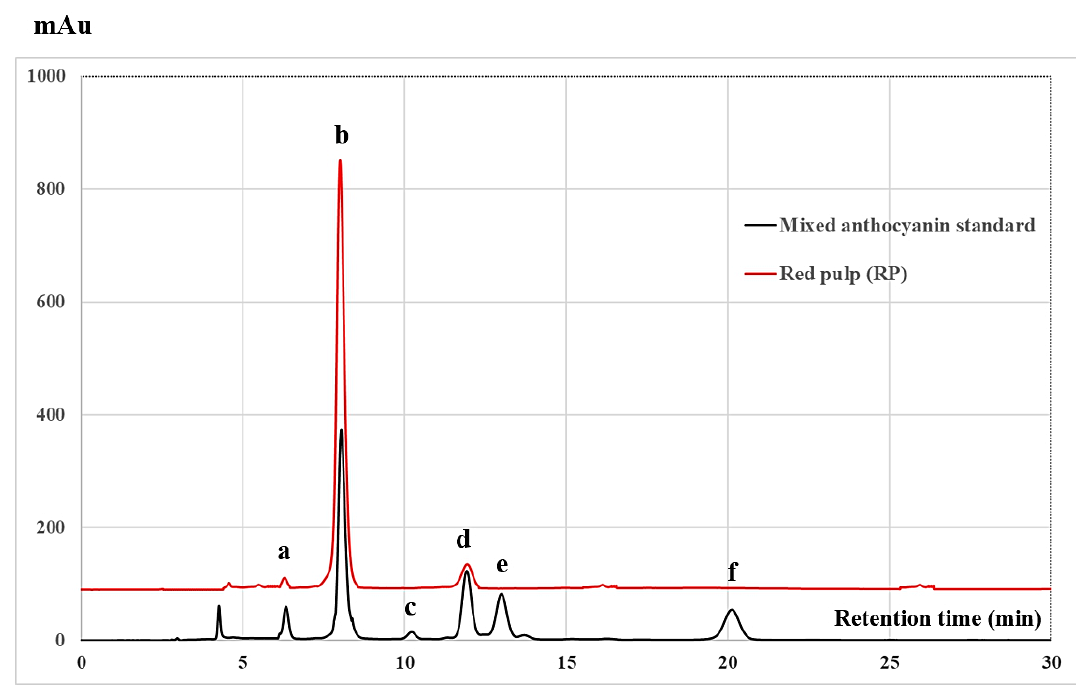
Figure 2. High-performance liquid chromatography (HPLC) chromatograms of mixed anthocyanin standards and red pulp (RP) extract. The peaks indicate ( a ) delphinidin 3-glucoside, ( b ) cyanidin 3-glucoside, ( c ) peonidin 3-glucoside, ( d ) pelargonidin 3-glucoside, ( e ) delphinidin, and ( f ) cyanidin.